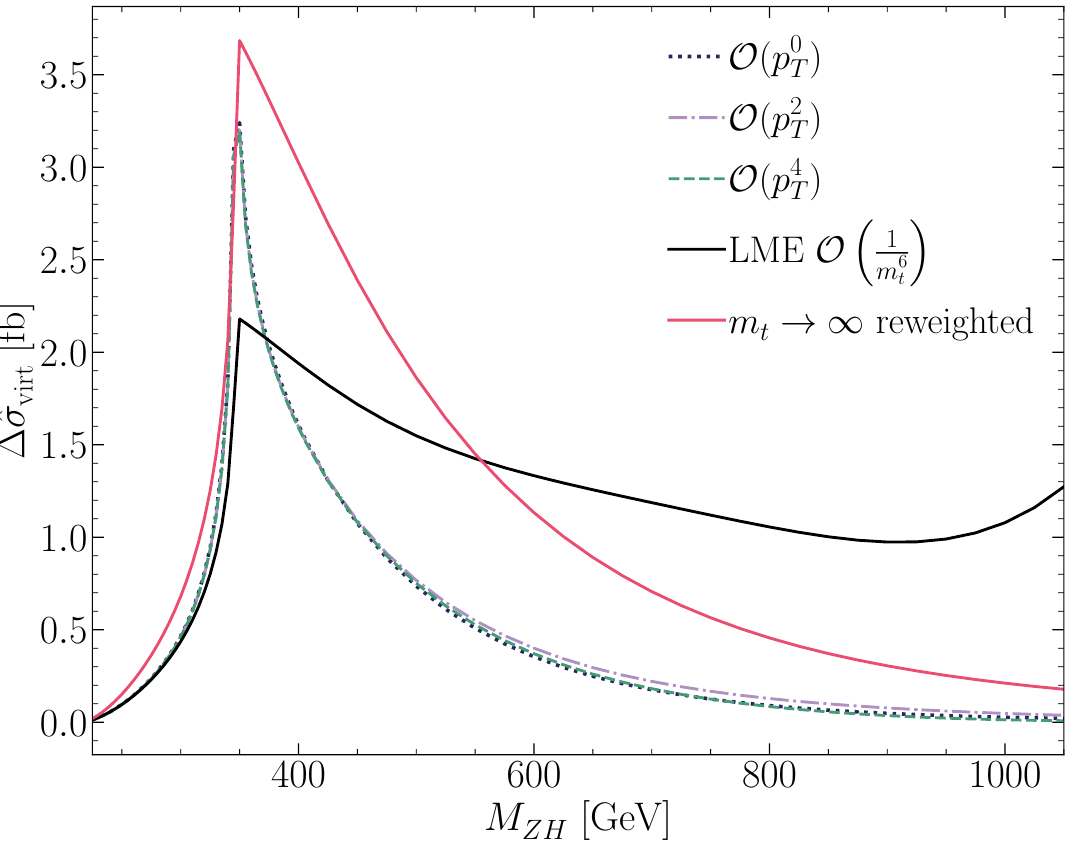
Figure 3 . ∆ˆ σ virt defined by eq. (6.2), shown as a function of M ZH . The various orders of the p -expansion are plotted as dashed lines, while the black and red continuous lines stand for the T LME and reweighted m t → ∞ results,